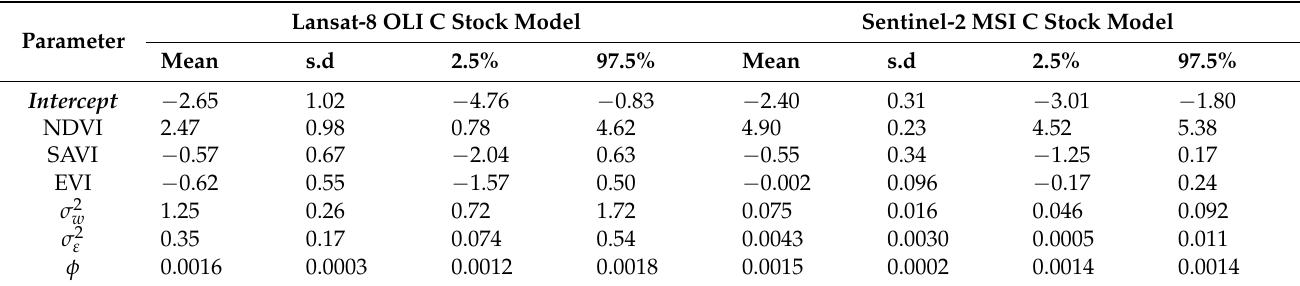
Table 1. Landsat-8 and Sentinel-2 derived predictors of C stock.